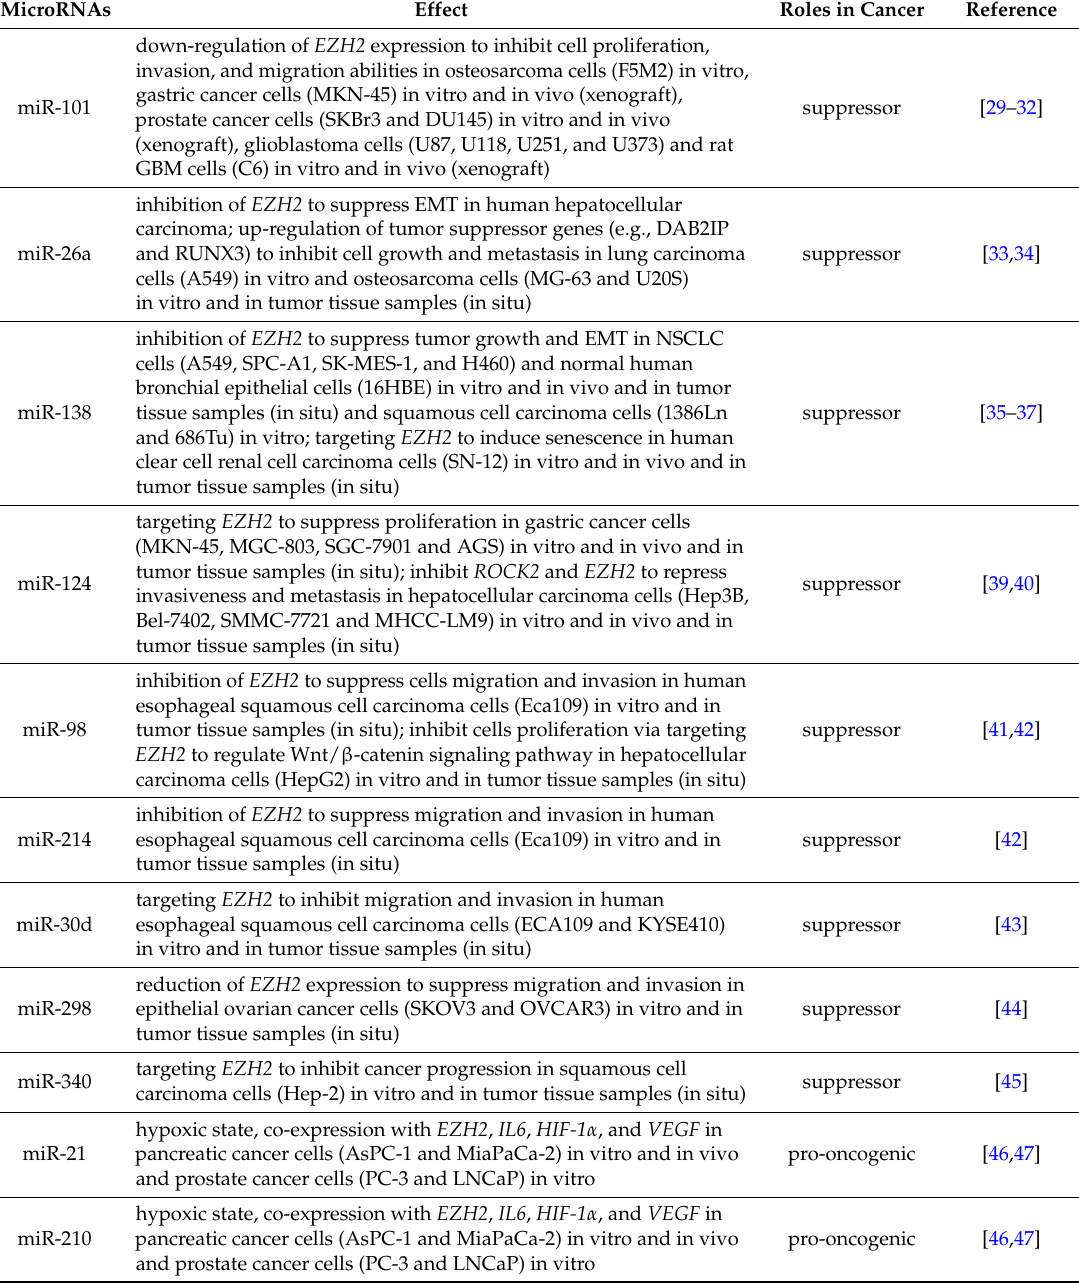
Table 2. The microRNAs related to EZH2 and their